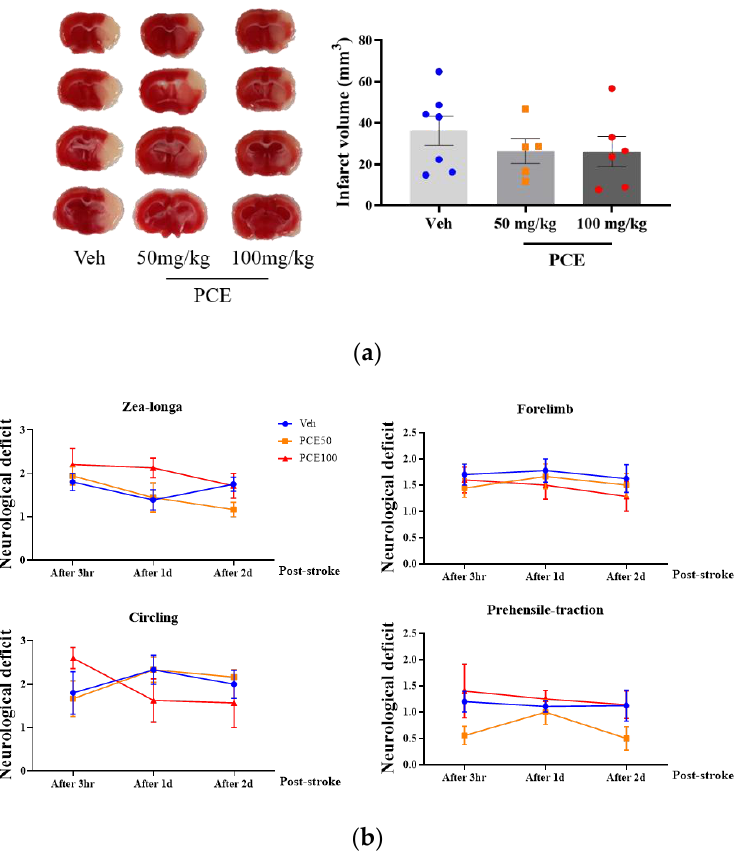
Figure 6. Post-treatment PCE diminishes infarct volume in ischemic stroke mouse model brain. ( a ) Representative 2,3,5-triphenyltetrazolium chloride (TTC)-stained sections of mouse brain 2 days post-stroke. Graph shows quantification of infarct volume. ( b ) Plots of four neurological subset test scores 3 h after perfusion. Post-treatment with PCE reduced the infarct volume by approximately 27% compared with the vehicle group and improved the neurological outcomes (Veh, n = 7; 50 mg/kg, n = 5; 100 mg/kg, n = 6). Values are mean ± SEM.